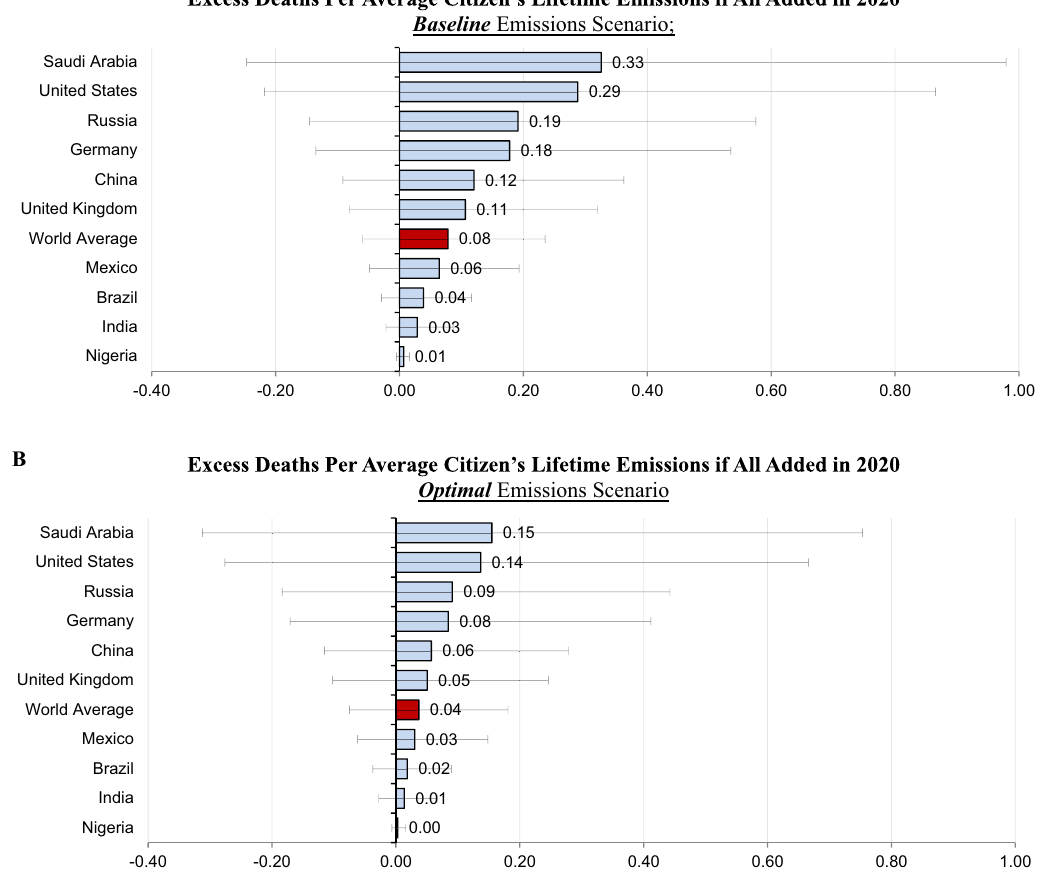
Fig. 1 Implications of the 2020 mortality cost of carbon. Average lifetime emissions are calculated as 2017 carbon dioxide emissions production per capita multiplied by 2017 life expectancy at birth. The error bars show the low (<10th percentile) and high (>90th percentile) mortality estimates (see “ Methods ” section for more details on uncertainty). A The 2020 MCC in the baseline emissions scenario is 2.26 × 10 − 4 excess deaths per metric ton of 2020 emissions in the central estimate. This implies that the lifetime emissions of an average American (1,276 metric tons) causes 0.29 excess deaths in expectation if all added in 2020, the lifetime emissions of an average Indian (127 metric tons) causes 0.03 excess deaths in expectation if all added in 2020, and the lifetime emissions of an average person in the world (347 metric tons) causes 0.08 excess deaths if all added in 2020. B The 2020 MCC